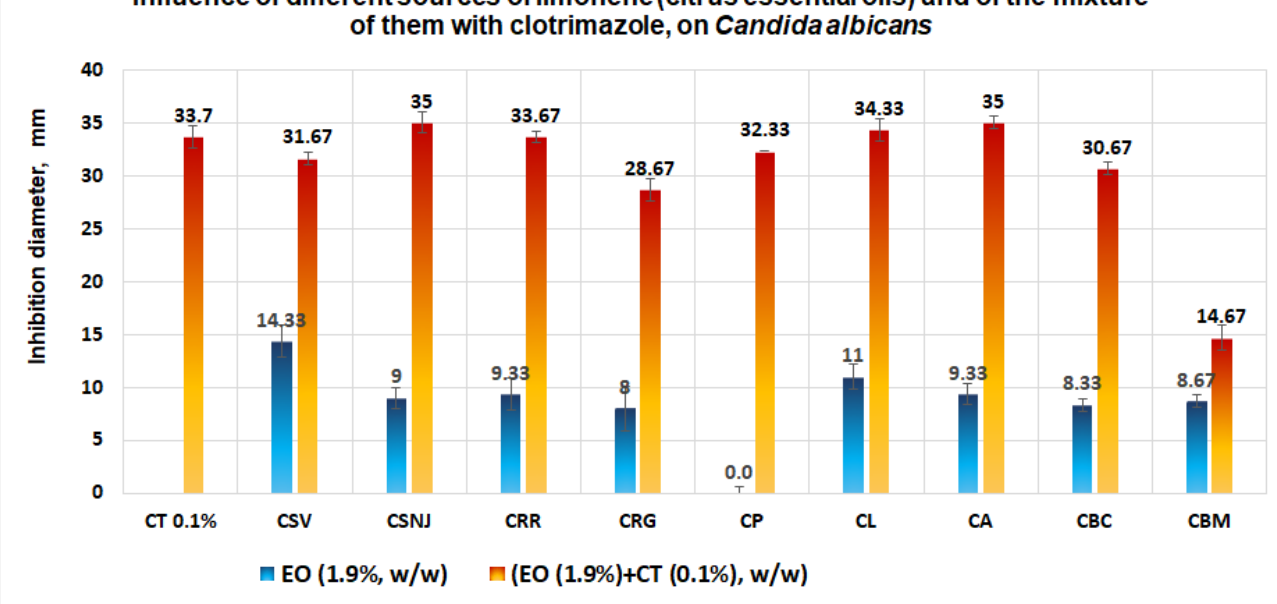
Figure 11. Influence of different sources of limonene (citrus essential oil, 1.9%, w/w) and of the mixture of them with clotrimazole (0.1%, w/w), on C. albicans . No synergism between clotrimazole and the different sources of limonene was observed.